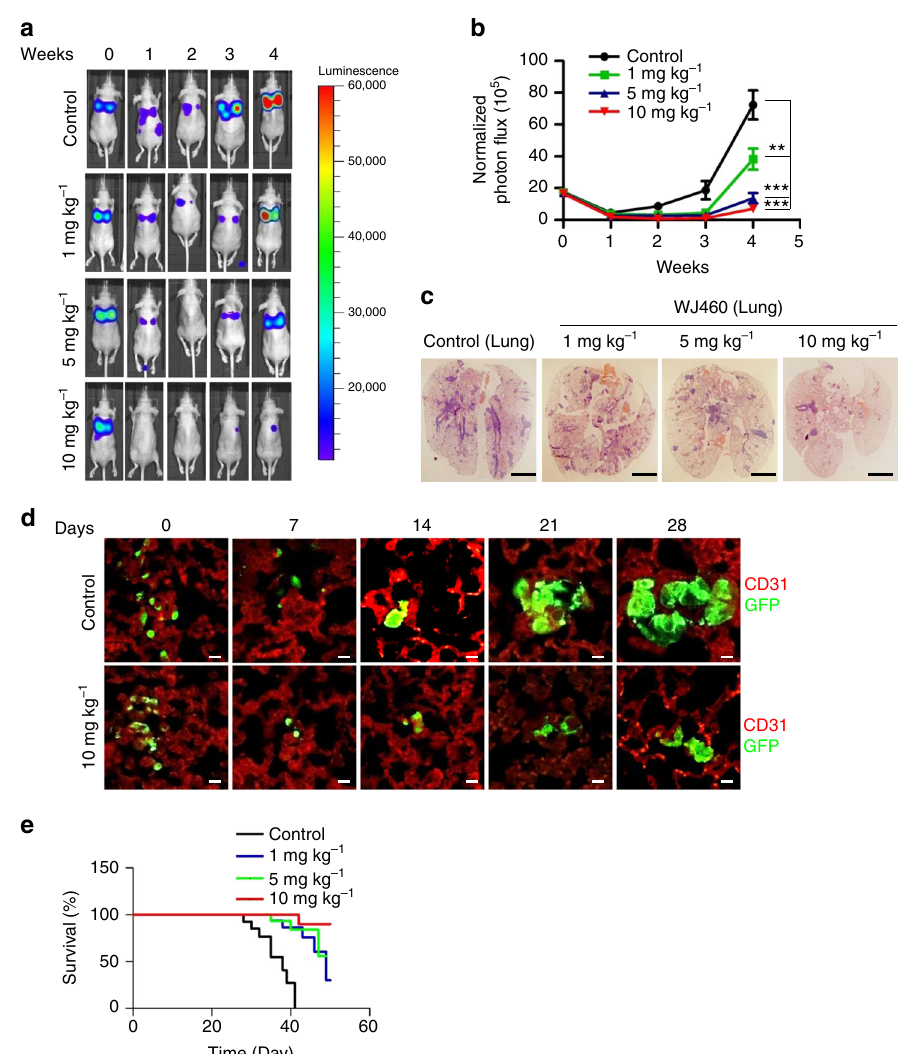
Fig. 3 WJ460 abrogates breast cancer lung extravasation and colonization. a MDA-MB-231-Luciferase cells were inoculated intravenously into female nude mice. DMSO or WJ460 was injected intraperitoneally on day 0. Lung metastasis was monitored by bioluminescence using an in vivo imaging system. b Quanti fi cation of bioluminescence. n = 6 mice per group. c H&E staining of lungs from the indicated groups upon harvest (day 28). Scale bars, 0.4 cm. d Mice were intravenously injected with MDA-MB-231-Luciferase-GFP cells and sacri fi ced at the indicated times. Lungs were stained for CD31 (red) and GFP (green). Confocal images were acquired. Scale bars, 10 μ m. n = 6 mice per group. e Overall survival rate of mice in different treatment groups. n = 8 mice per group. ** p < 0.01, *** p <